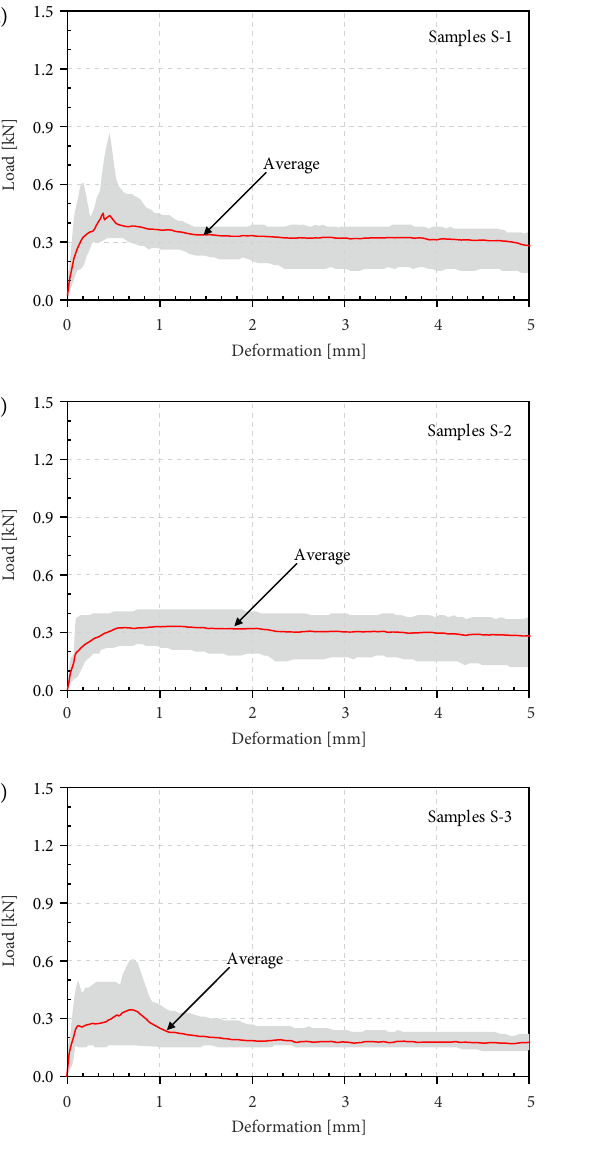
Figure 6. Load – deformation curves of flexible ties in tension: a, c, e – masonry of solid bricks, b, d, f – masonry of perforated